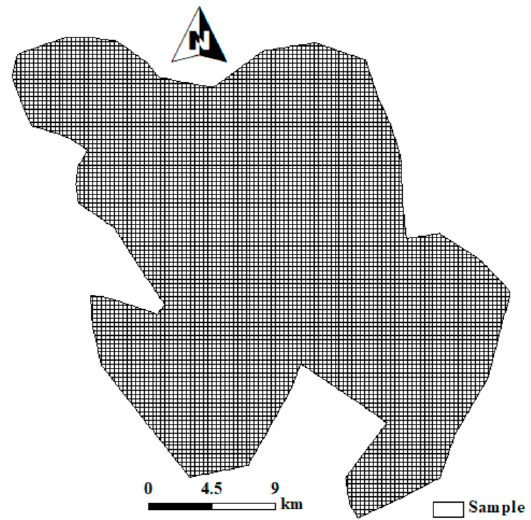
Figure 2. Samples (300 × 300